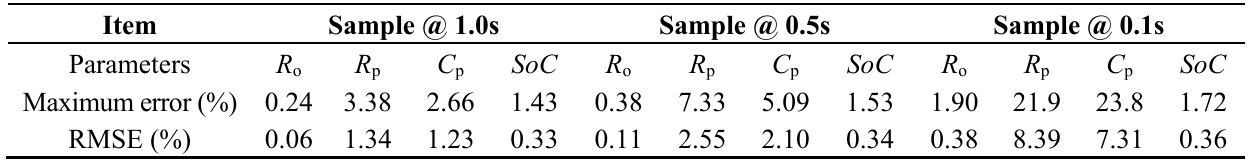
Figure 7. SoC estimation results at the sampling periods of ( a ) 1 s, ( b ) 0.5 s, ( c ) 0.1 s; and the SoC error at the sampling periods of ( d ) 1 s, ( e ) 0.5 s, ( f ) 0.1 s. Table 6. The statistical error analysis of model parameters and SoC estimation error. RMSE: root-mean-square